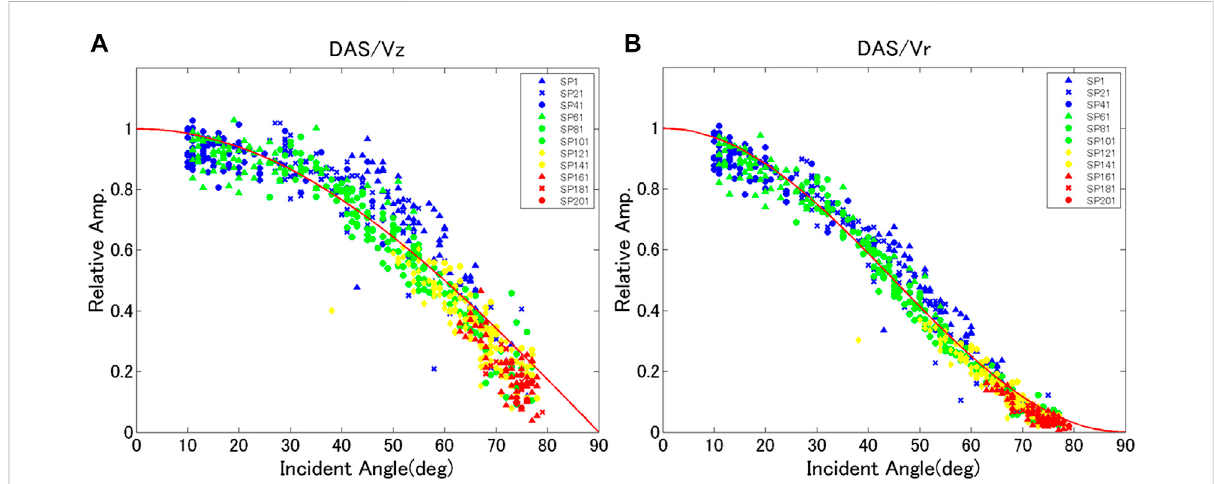
FIGURE 9 Incident angle dependency of DAS amplitude over the geophone amplitude evaluated by the direct P-wave. (A) Vz amplitude for geophone data. (B) Geophone total amplitude. The colors and markers correspond to different shot points.